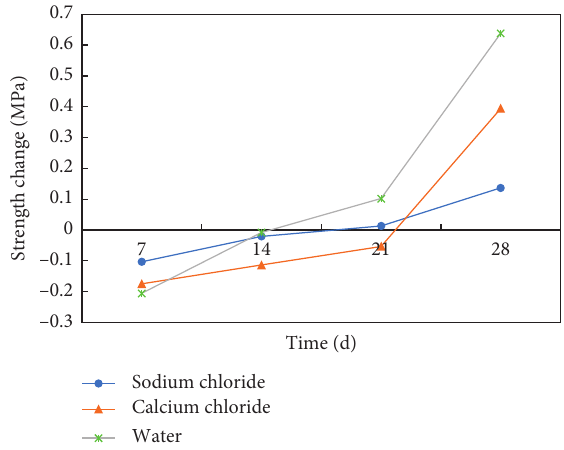
Figure 15: Strength change rate of the cylindrical specimen of HWC materials after erosion.